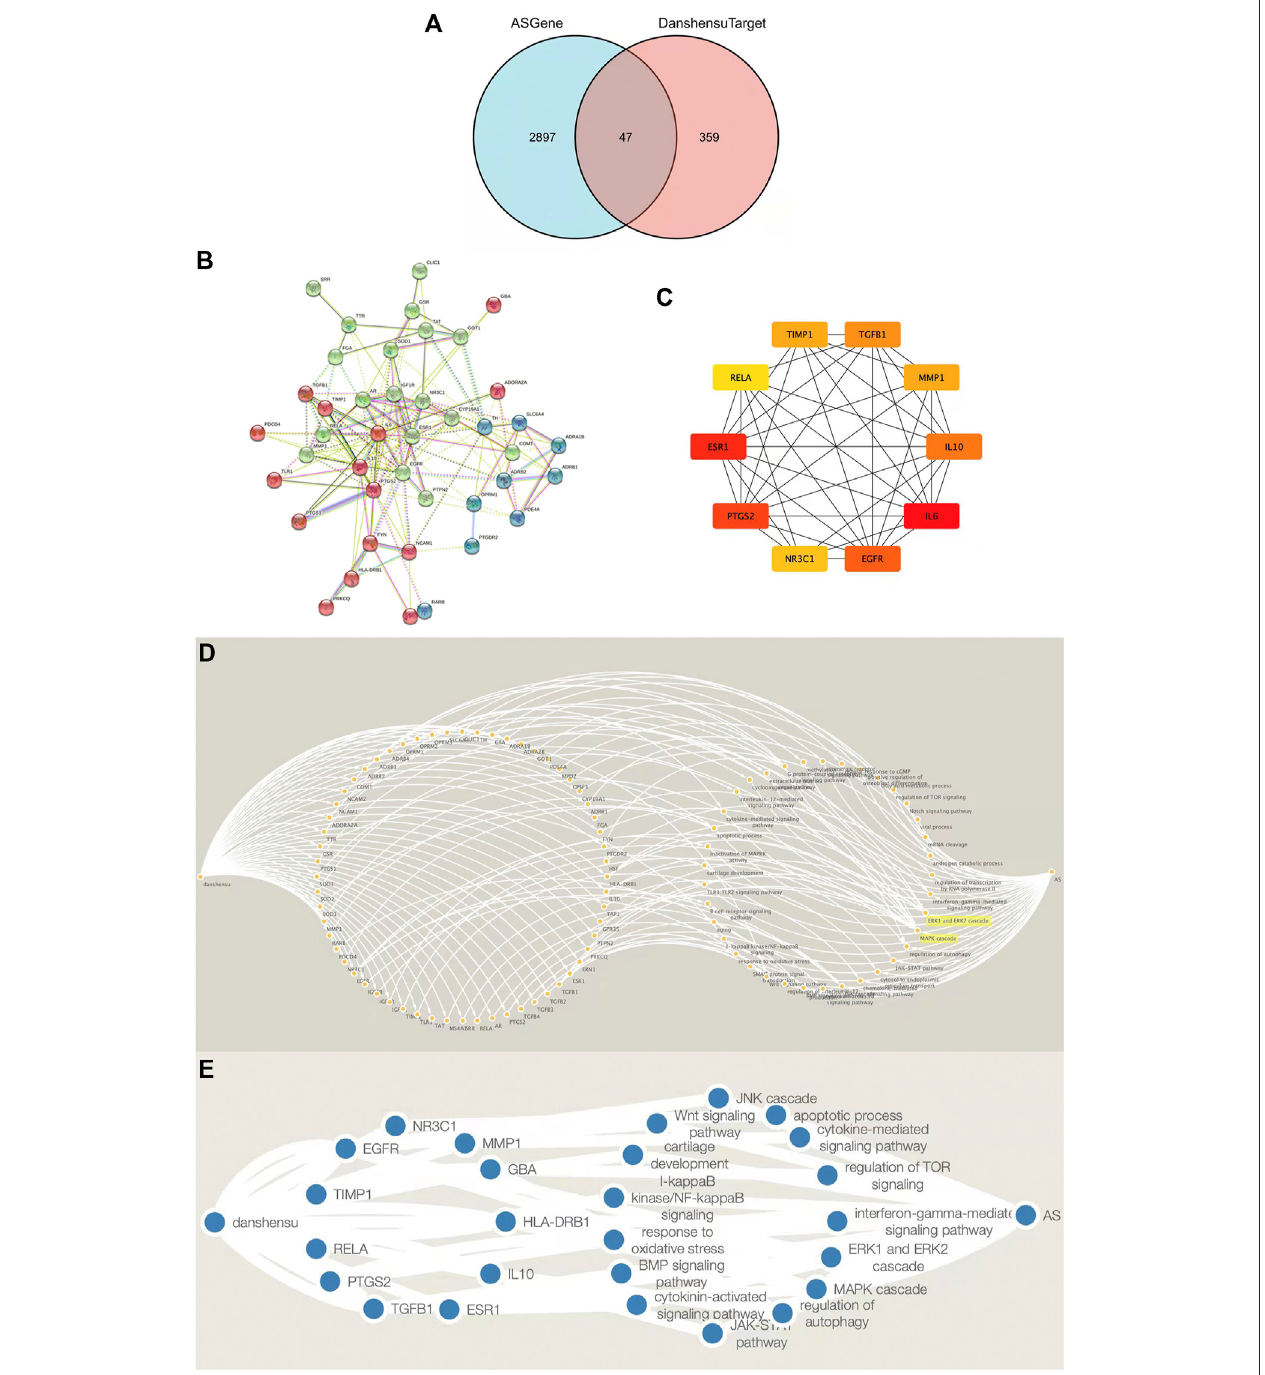
FIGURE 3 | Screening and PPI network construction and Target-signaling pathway interaction network of Danshensu anti-AS targets. (A) Venn diagram of target genes of Danshensu in AS. (B) PPI network of Danshensu targets in AS. (C) Venn diagram of hub genes of Danshensu in AS. (D) Target – signaling pathway interaction network of Danshensu in AS. (E) Target-signaling pathway interaction network of hub genes in Danshensu against AS. Note: The left single node was Danshensu, the right single node was AS, the left nodes in circular arrangement were overlapping Danshensu-AS targets, and the left nodes in circular arrangement were signaling pathways.